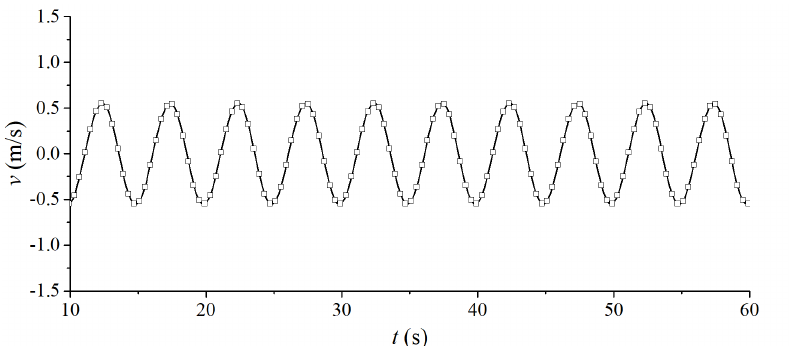
Figure 14. Velocity time histories of the floater when linear damping coefficient C is 30,000